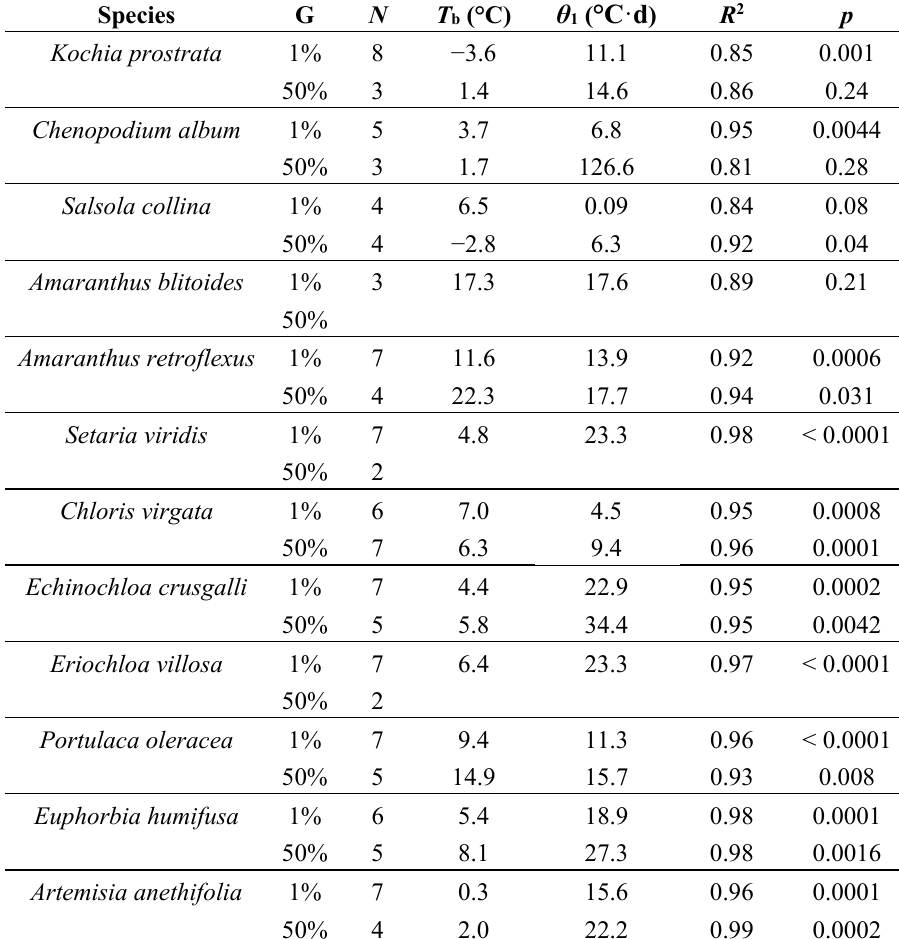
Table 2. Estimated parameters of thermal time model for 1% and 50% germination percentiles (G) of C 4 species at suboptimal